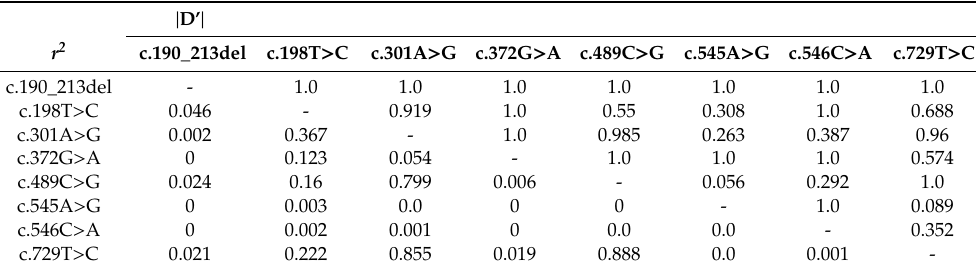
Table 3. Linkage disequilibrium (LD) of 8 PRNP polymorphisms in dogs.